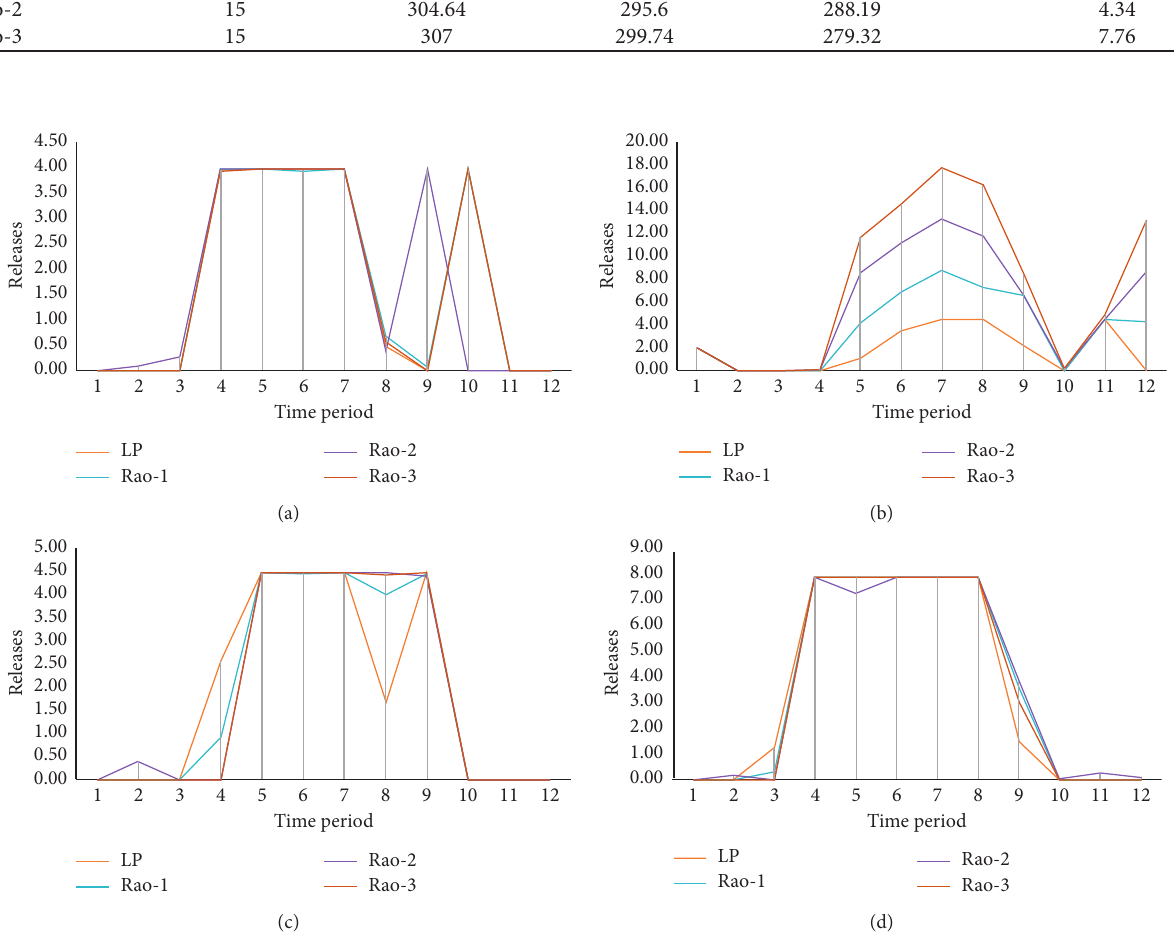
Figure 4: Release pattern for the CFRO system obtained through Rao algorithms. (a) Reservoir 1. (b) Reservoir 2. (c) Reservoir 3. (d) Reservoir